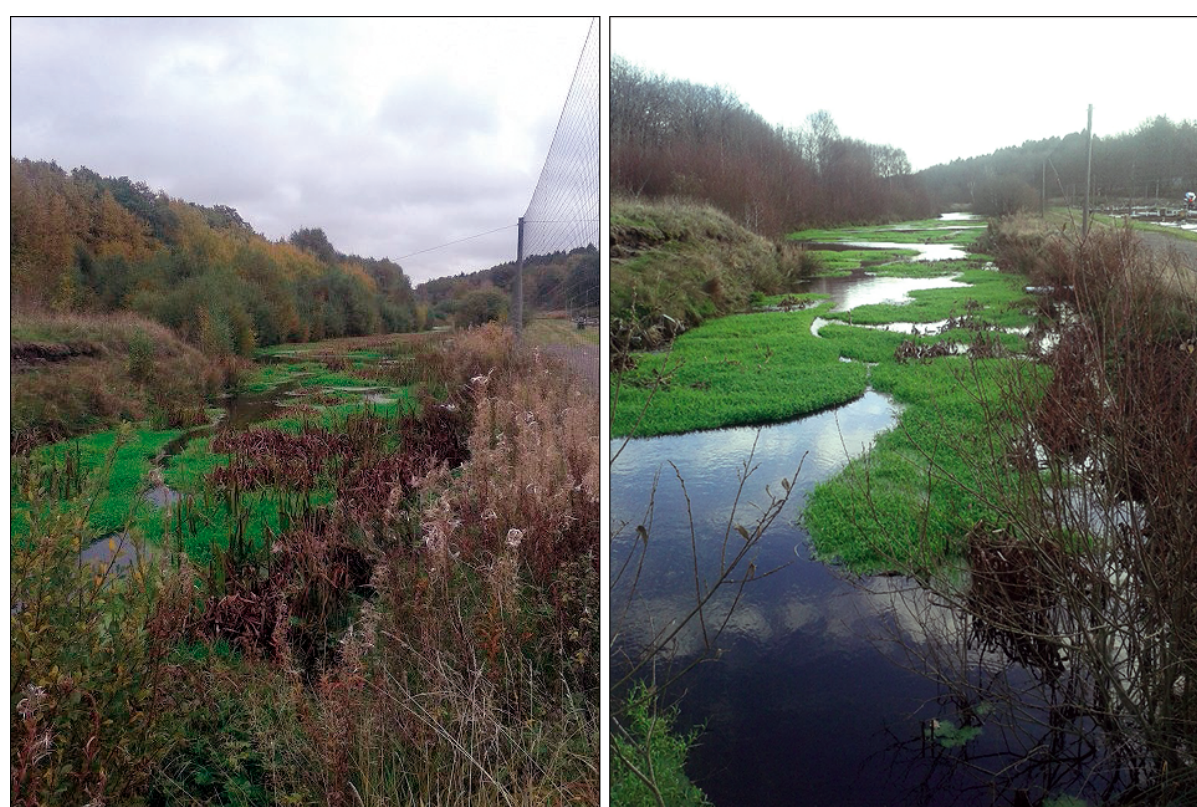
Fig. 7. The wetland in October (left) and at the end of November (right) towards the end of the growing